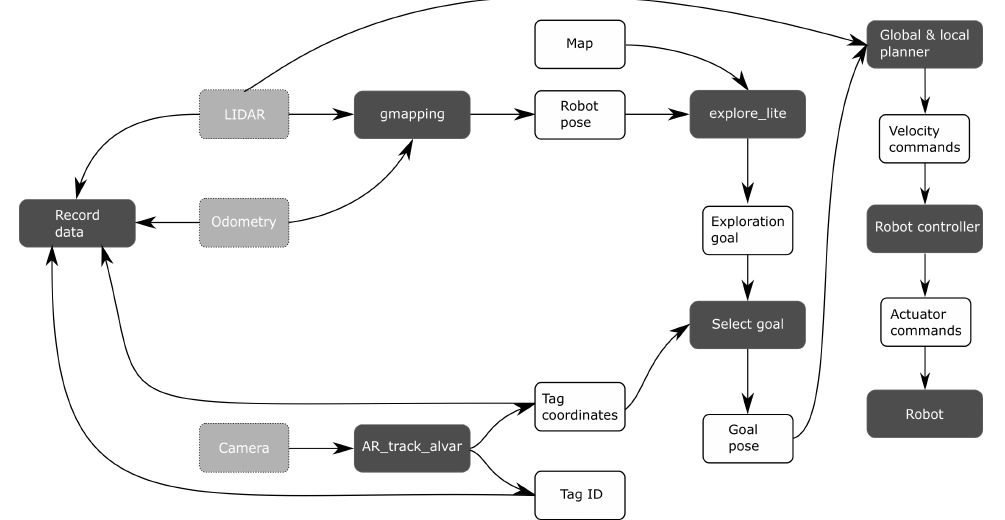
Figure 6. Overview of data flow during fully autonomous